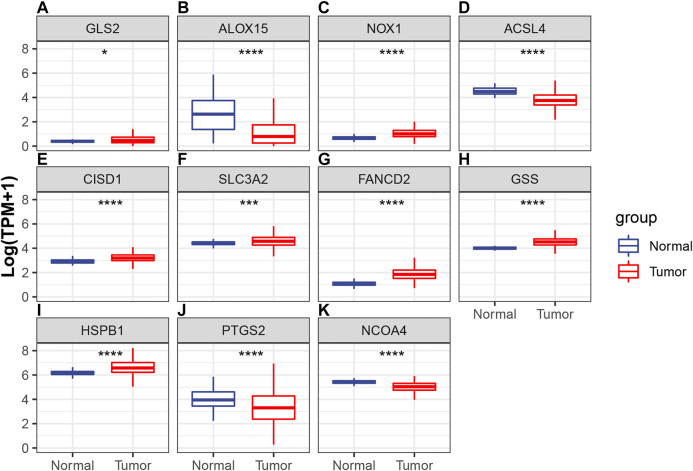
Comparisons of the expression profiles of 11 selected ferroptotic regulators between LUAD and normal tissue, which included (A) GLS2, (B) ALOX15, (C) NOX1, (D) ACSL4, (E) CISD1, (F) SLC3A2, (G) FANCD2, (H) GSS, (I) HSPB1, (J) PTGS2, and (K) NCOA4. *p < 0.05; ***p < 0.001; ****p < 0.0001.